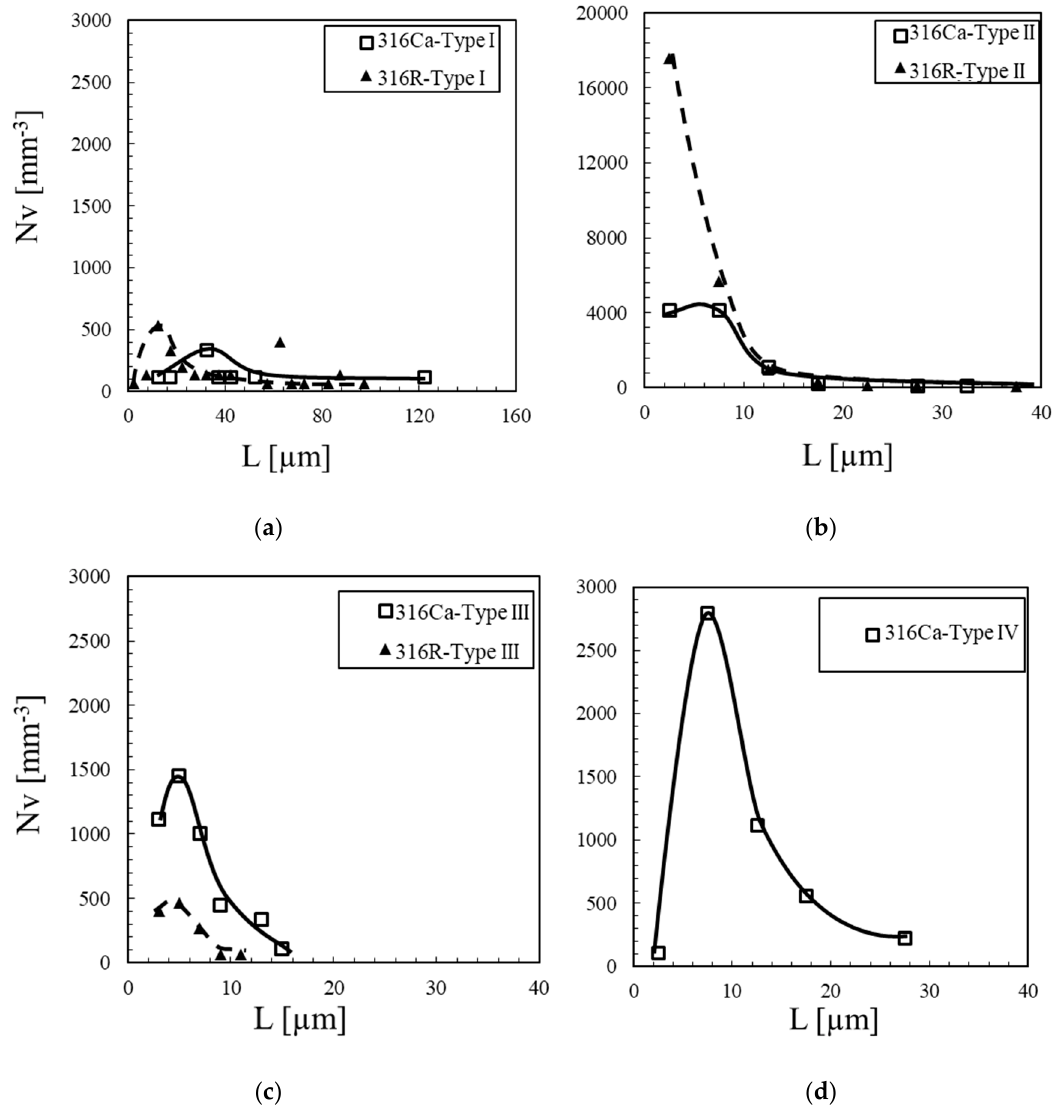
Figure 5. Particle size distributions of different NMI types observed in the metal samples of 316R and 316Ca steel bars.